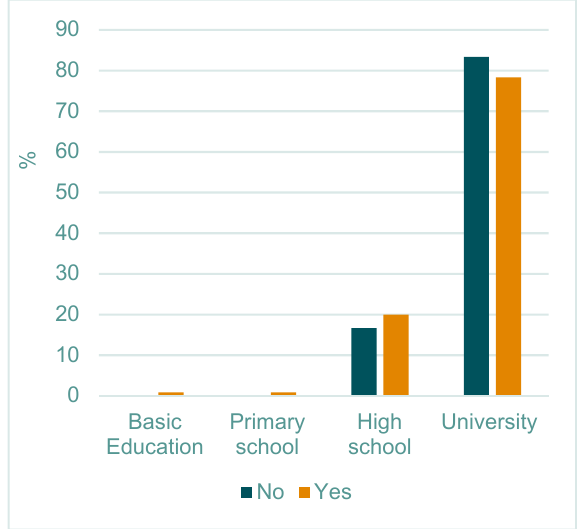
Figure 9. Response to the question “Based on your sensitivity to the presented maps, are you willing to make changes in your neighborhood?”, by sex.